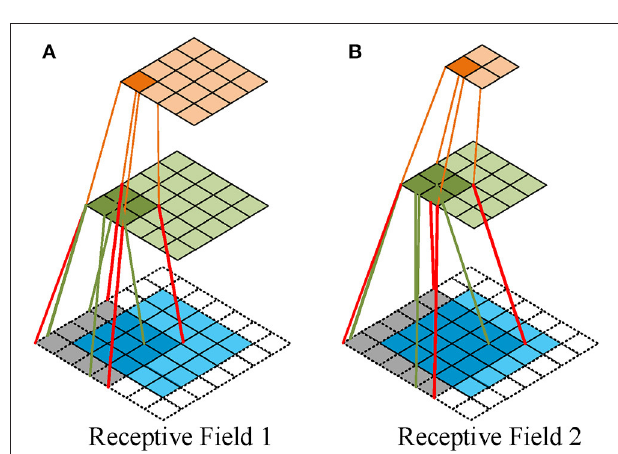
FIGURE 2 | Receptive field a deep CNN. (A) The first convolving: a 3 × 3 kernel over a 5 × 5 input padded with a 1 × 1 border of zeros using unit strides. The second convolving: a 2 × 2 kernel using unit strides. (B) The first convolving: a 4 × 4 kernel over a 5 × 5 input padded with a 1 × 1 border of zeros using unit strides. The second convolving: a 2 × 2 kernel using 2 × 2